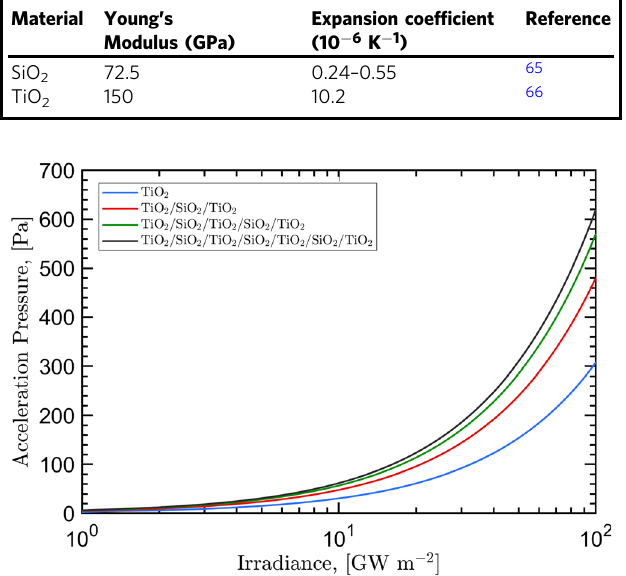
Fig. 10 Maximum acceleration pressure undergone by TiO 2 -based lightsails. The maximum acceleration pressure to reach β f in the beamer reference frame for the TiO 2 -based lightsail structures have been computed for different laser irradiances.